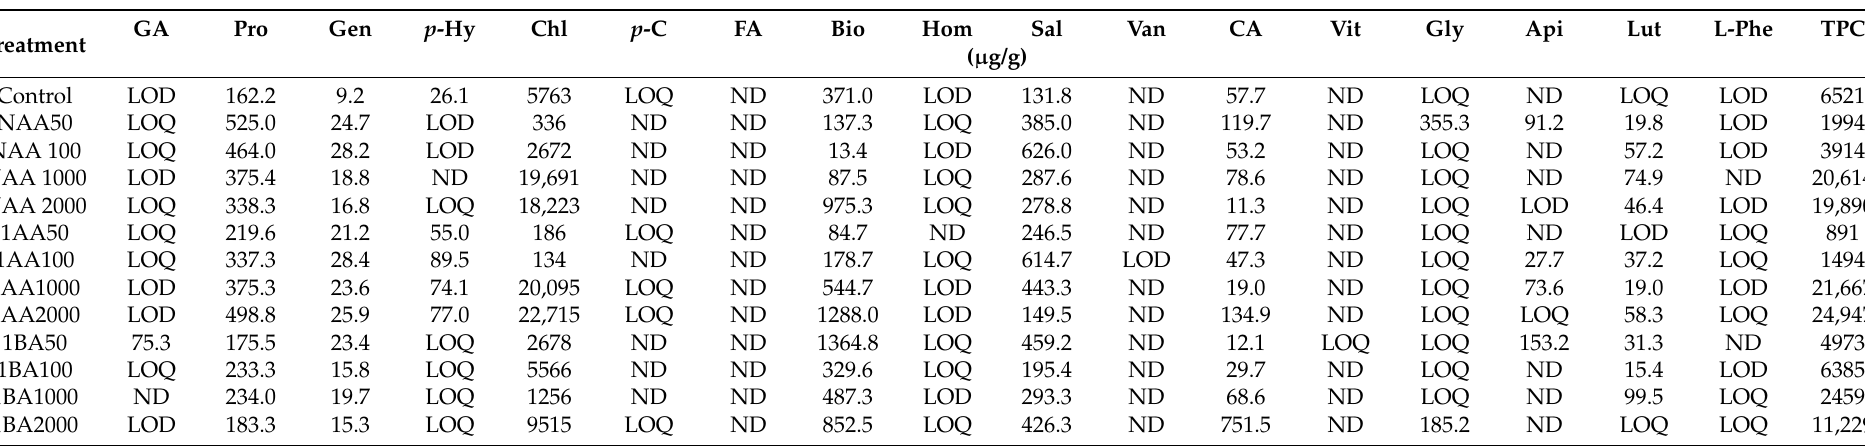
Table 3. Distribution of total phenolic compounds in C. indicum treated with different concentrations of